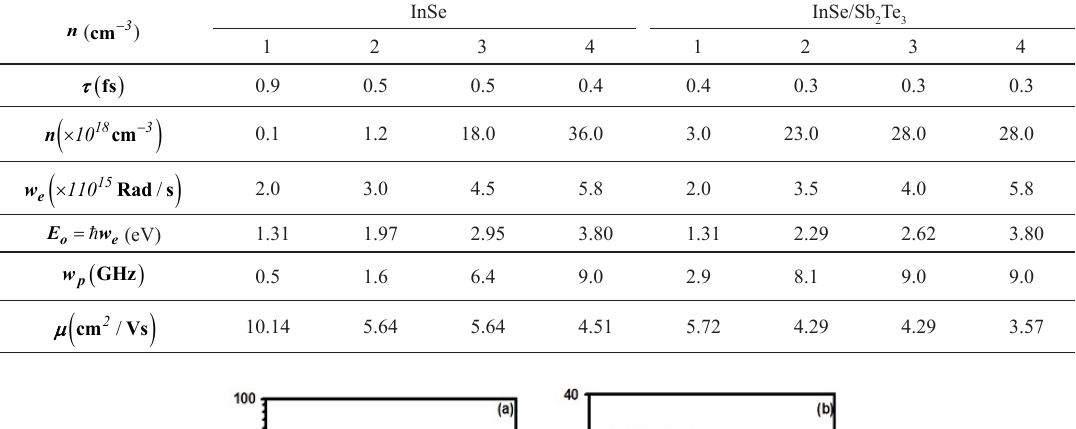
Te interfaces. 2 3